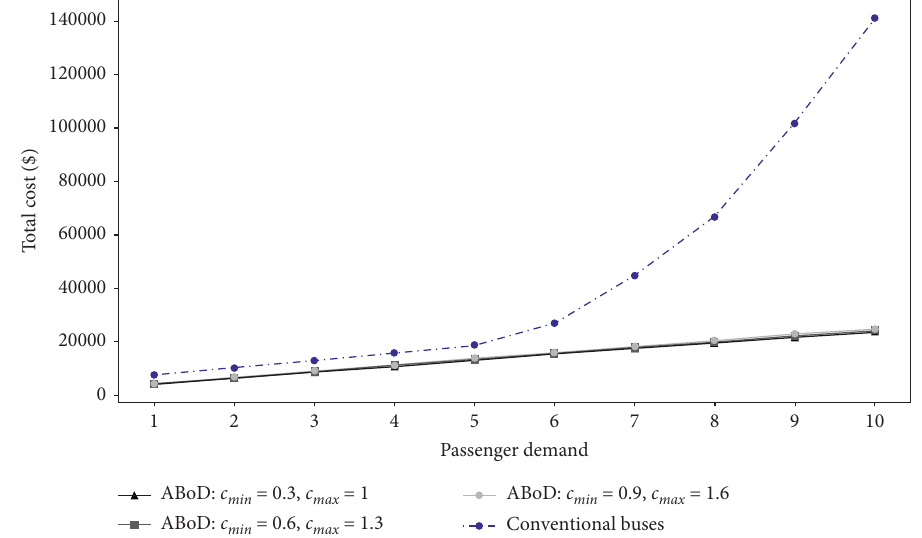
Figure 8: The total cost comparison between ABoD and conventional